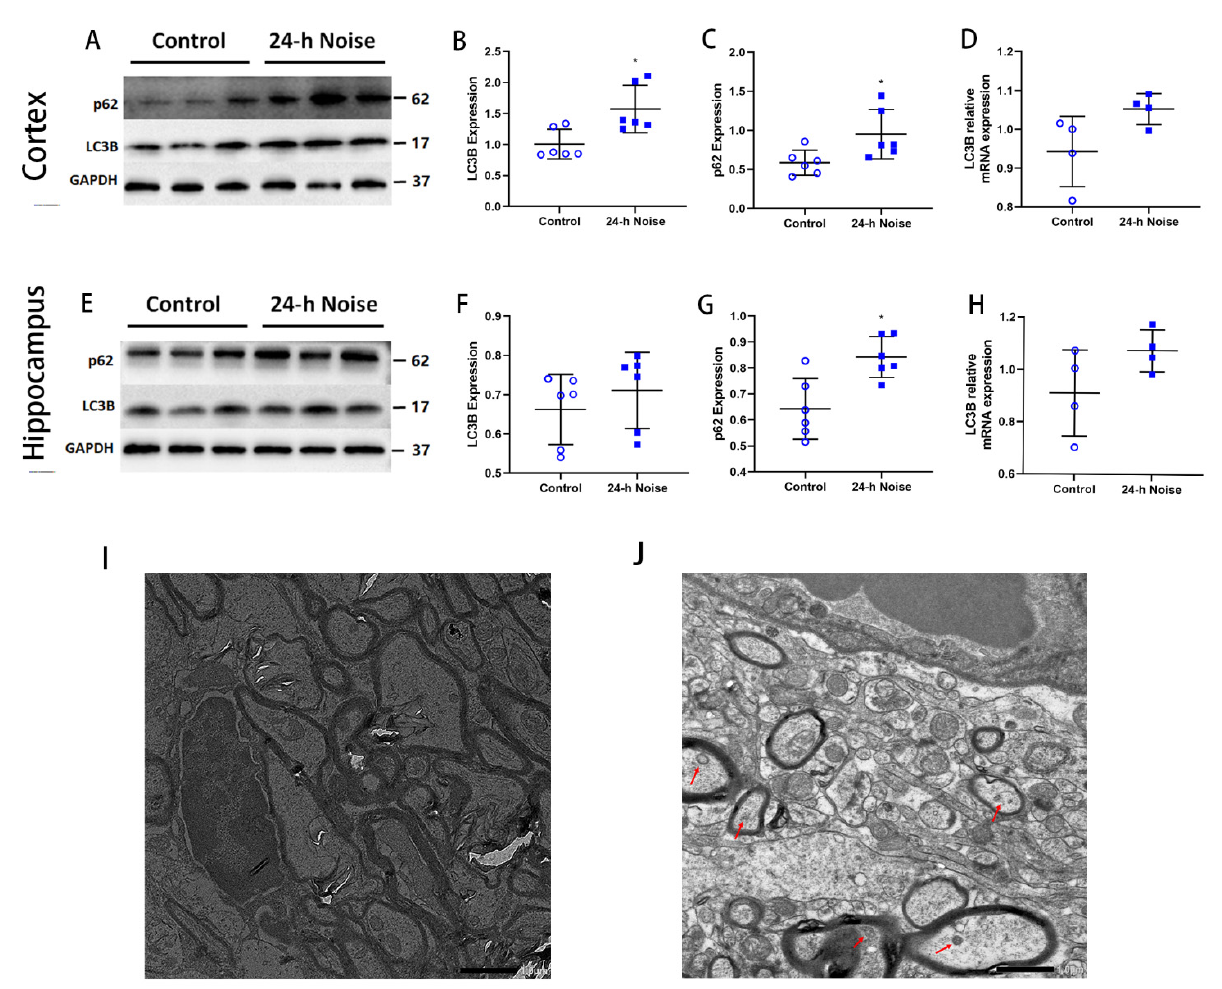
Figure 4. Around-the-clock noise (24 h/day) exposure increases AP formation. ( A , E ) Western blot of p62 and LC3B expression in the cortex and hippocampus. ( B , C , F , G ) Quantification data showed that around-the-clock noise (24 h/day) increases the expression of p62 and LC3B in the cortex and hippocampus ( n = 6 per group). ( D , H ) The expression of LC3B at the RNA level in the cortex and hippocampus ( n = 4 per group). ( I , J ) The ultrastructural hippocampus changes were observed with transmission electron microscopy (scale bar: 1 μ m). * p < 0.05.